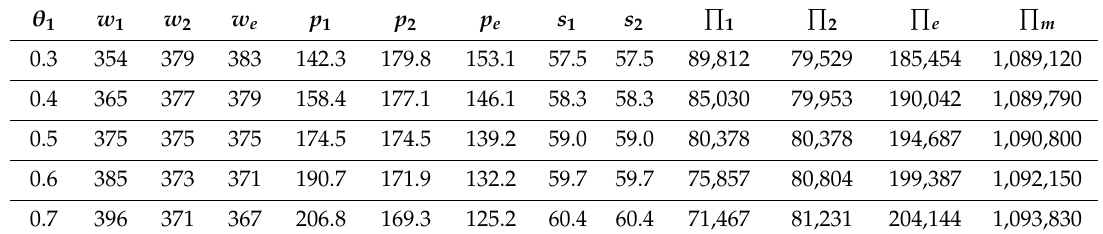
Table 4. The e ff ect of θ 1 on decisions by applying strategy